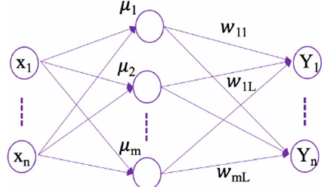
Figure 2. Structure of the neural